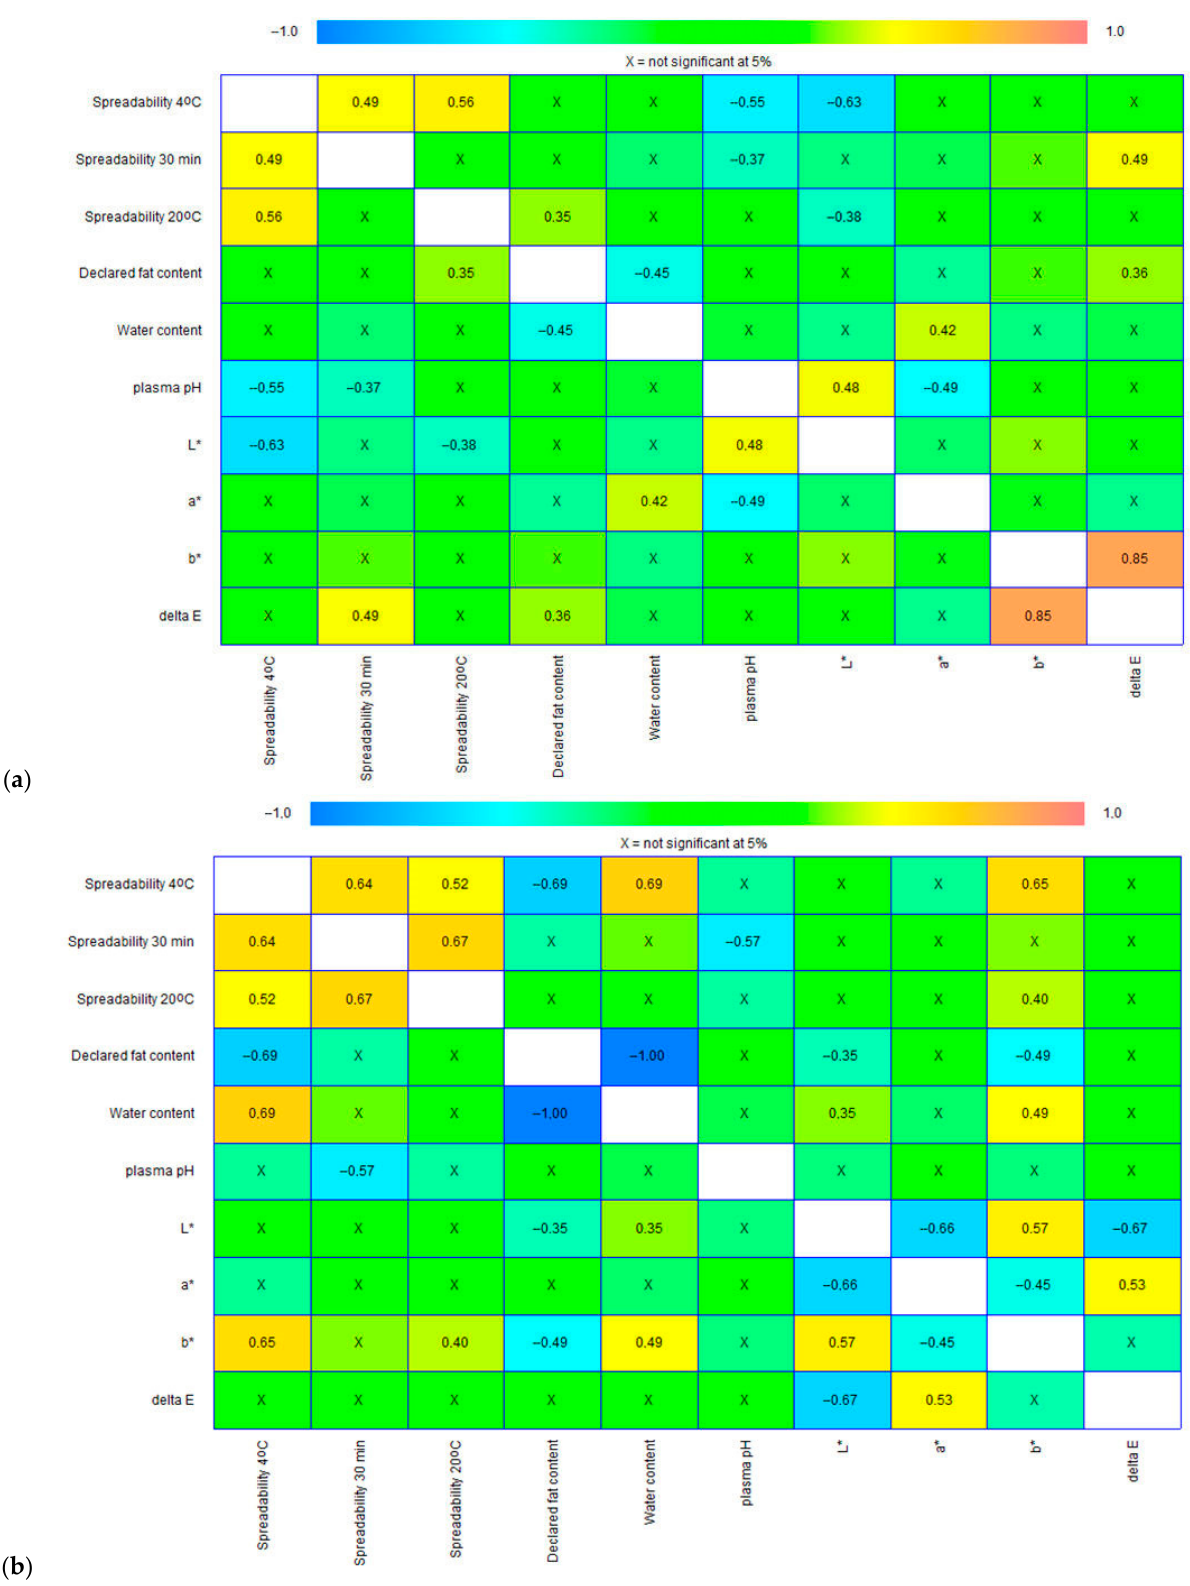
Figure 2. Graphs of correlation matrix showing the relationship between the spreadability, selected physicochemical properties, and the color components of butter and butter substitute samples ( a ) and butter substitute samples alone ( b ) measured at different temperatures (with a confidence level of